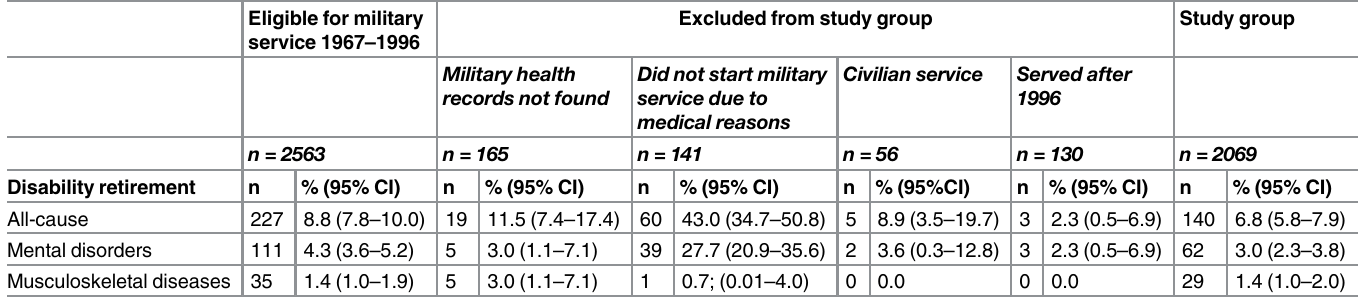
Table 1. Cumulative incidence (%) of disability retirement in the random population